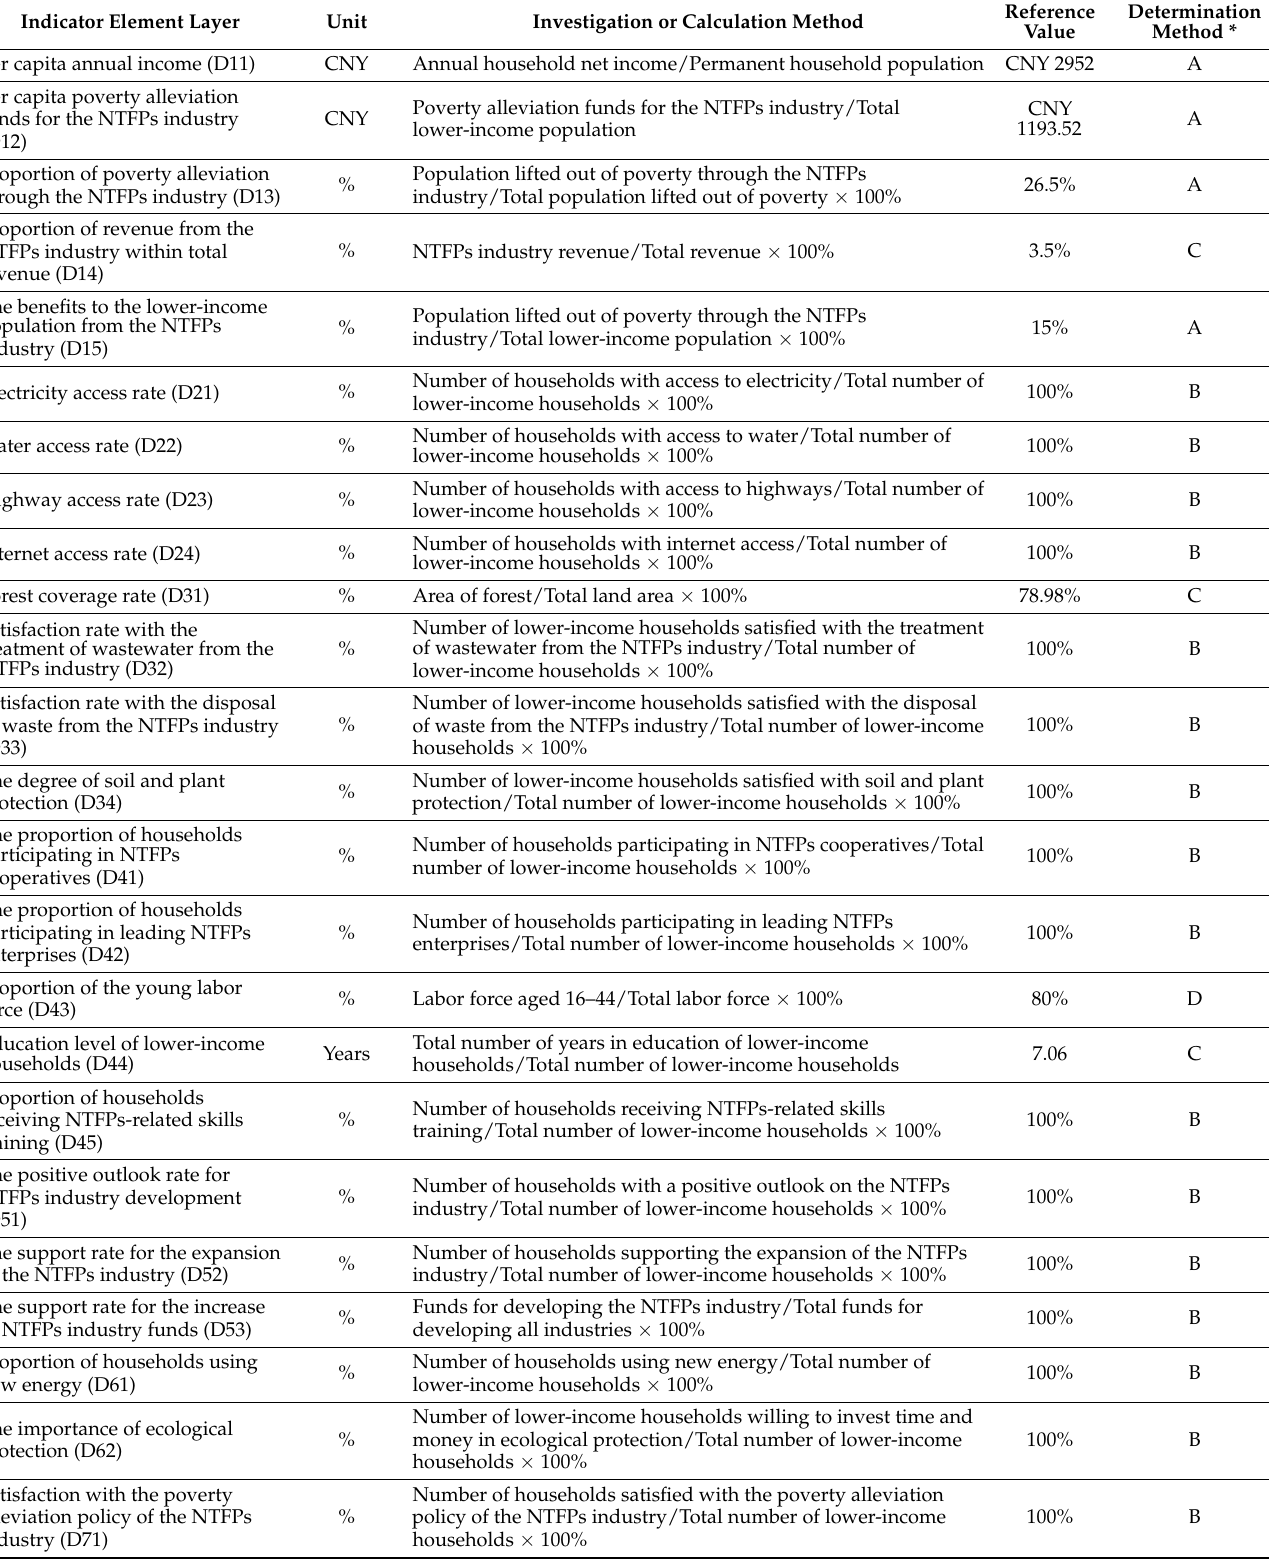
Table 8. The reference values of each index element